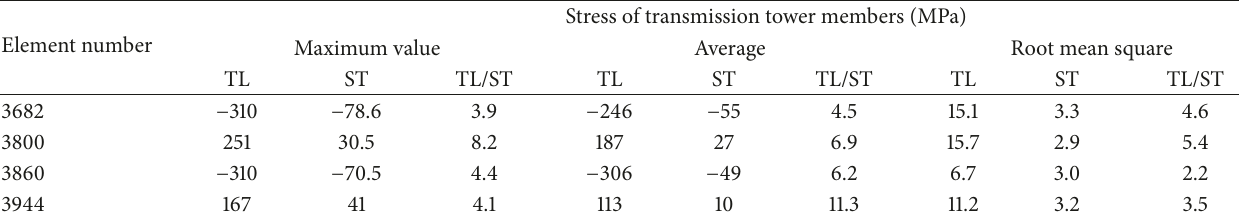
Table 10: Comparison of the dynamic stress results of the main members of the transmission tower in the tower-line system with the corresponding single tower under a wind speed of 𝑈 10 = 25.3